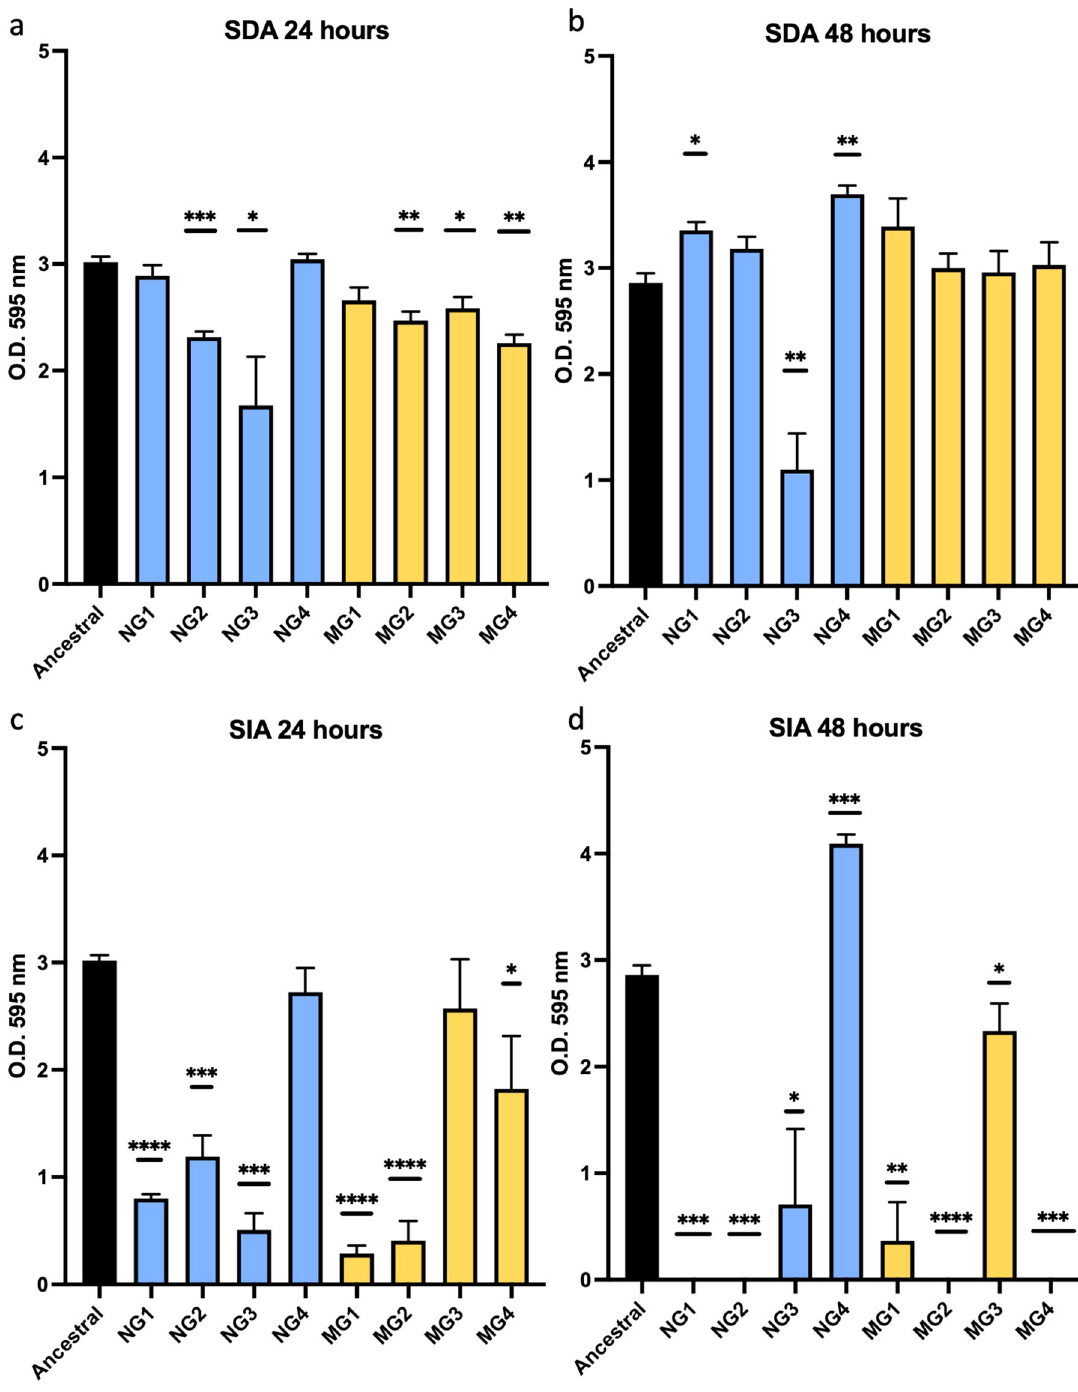
Fig. 2 Adhesion phenotypes vary between biological replicates. Sucrose-dependent (SDA) was assessed after ( a ) 24- and ( b ) 48 h of static growth in BHI supplemented with 0.1% sucrose using the 100-day populations. Sucrose-independent adhesion (SIA) was assessed after ( c ) 24- and ( d ) 48 h of static growth in BHI supplemented with 0.1% glucose using the 100-day populations. Data was plotted in GraphPad Prism ® 9.2.0 and unpaired t -tests with 95% con fi dence were used to calculate signi fi cant differences for pairwise comparisons between the ancestral and each treatment populations. Error bars are s.e.m. and signi fi cance is reported as a two-tailed p-value where * p ≤ 0.05, ** p ≤ 0.01, *** p ≤ 0.001 and **** p ≤